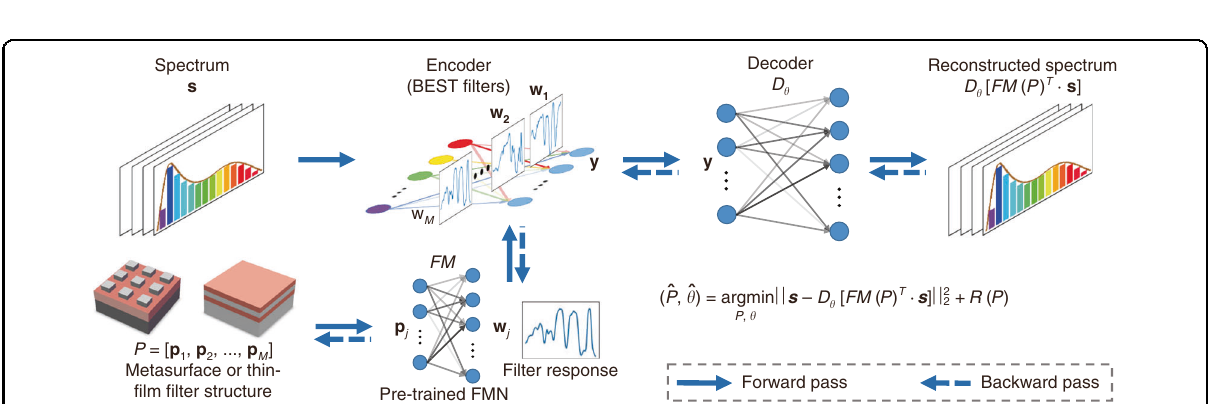
Decoder D (cid:6)